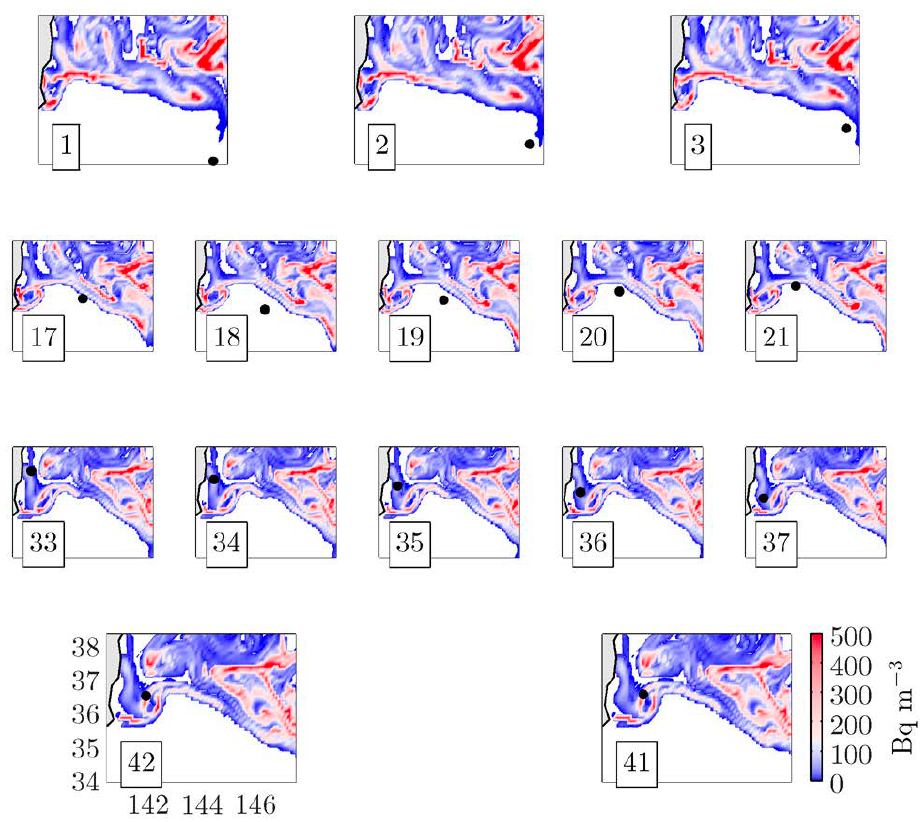
Fig. 7. Modeled mixed-layer 137 Cs concentration from the oceanic source (in color) at times corresponding to select stations. Black dot shows the station position. The number outlined in the lower left corner indicates station number (see Figure 1d).